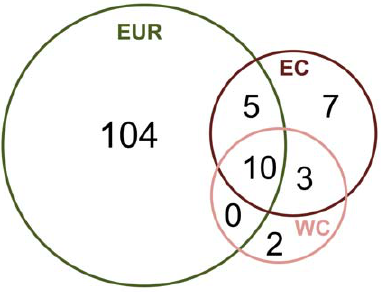
Figure 4. Venn diagram depicting numbers of unique and shared L.littorea haplotypes among regions. Regions are Europe (EUR), North American East Coast (EC) and West Coast (WC). From this diagram it is clear that EUR has a vast amount of unique diversity (and overall diversity); that the WC is a large subset of the EC diversity; and that there is no direct connection between the WC and EUR given that there are no haplotypes just shared between the two regions.